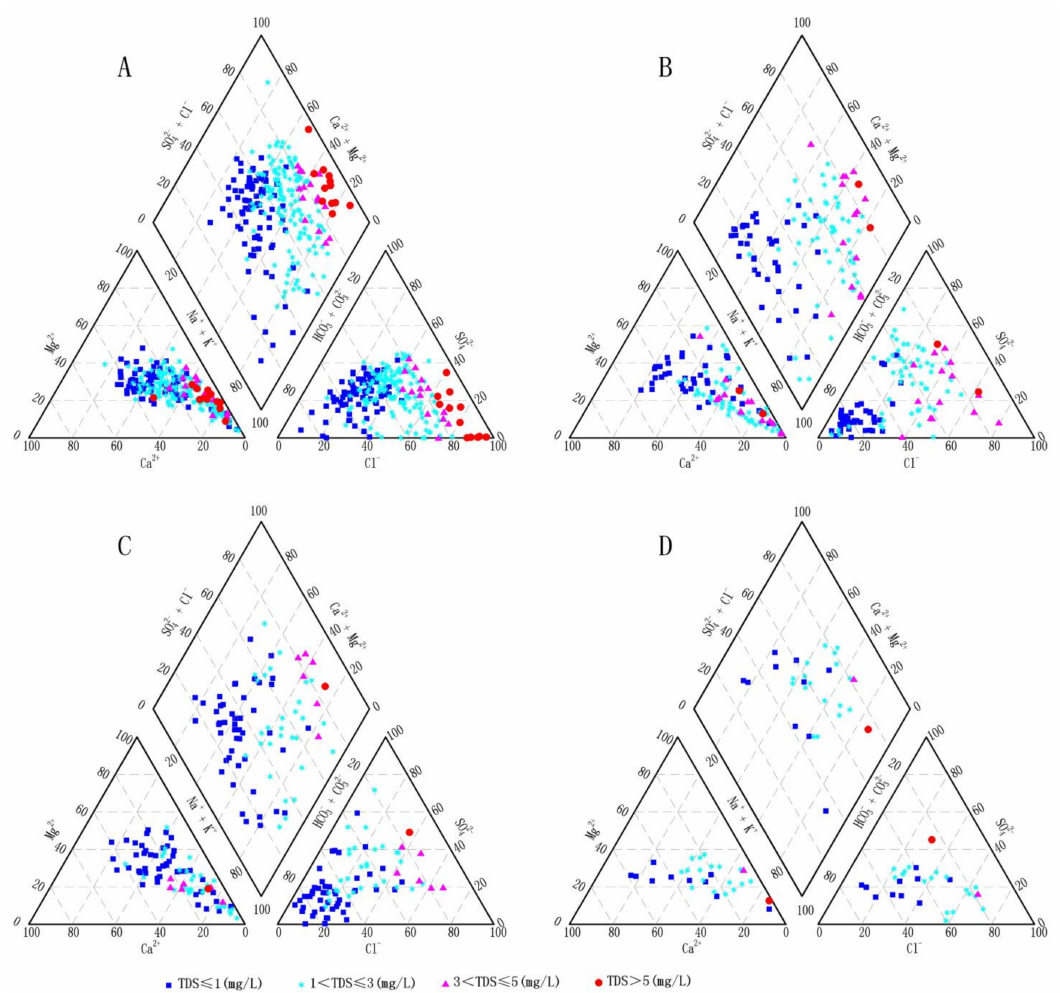
Figure 4. Piper diagram of high-arsenic shallow groundwater quality in four hydrogeological